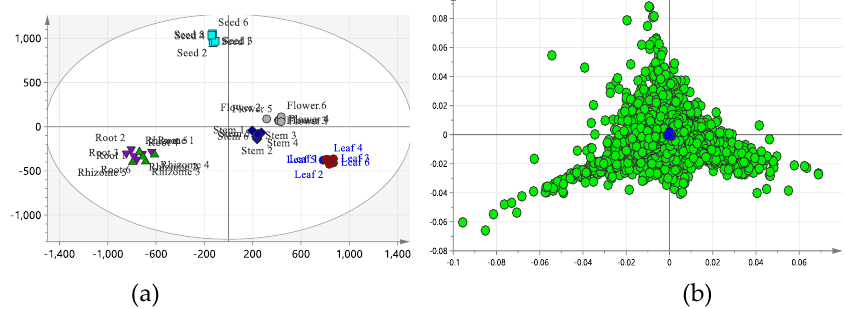
Figure 4. OPLS-DA score plots and loading plots. ( a ) Score plots; ( b ) loading plots. The R 2 X, R 2 Y and Q 2 values of OPLS-DA were 0.726, 0.987 and 0.973, respectively.